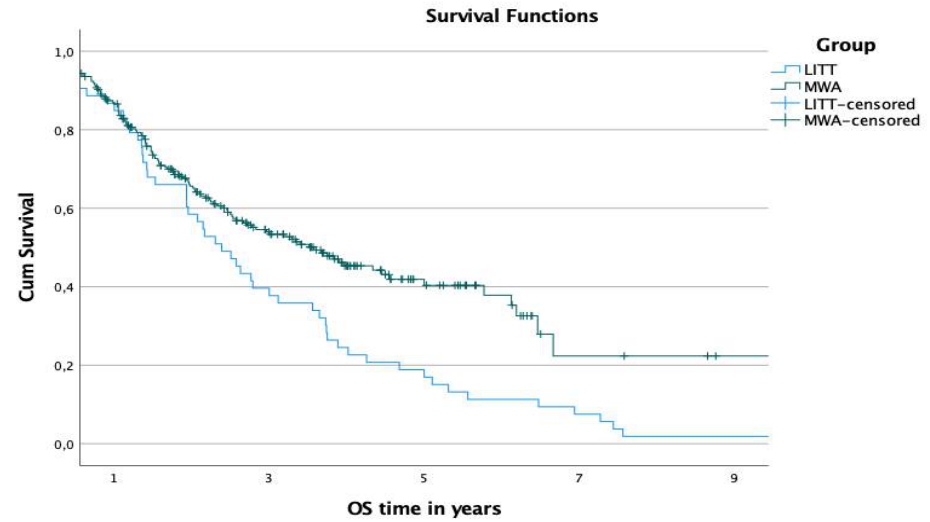
Figure 4. Comparison of OS rates of both groups starting at the date of ablation.